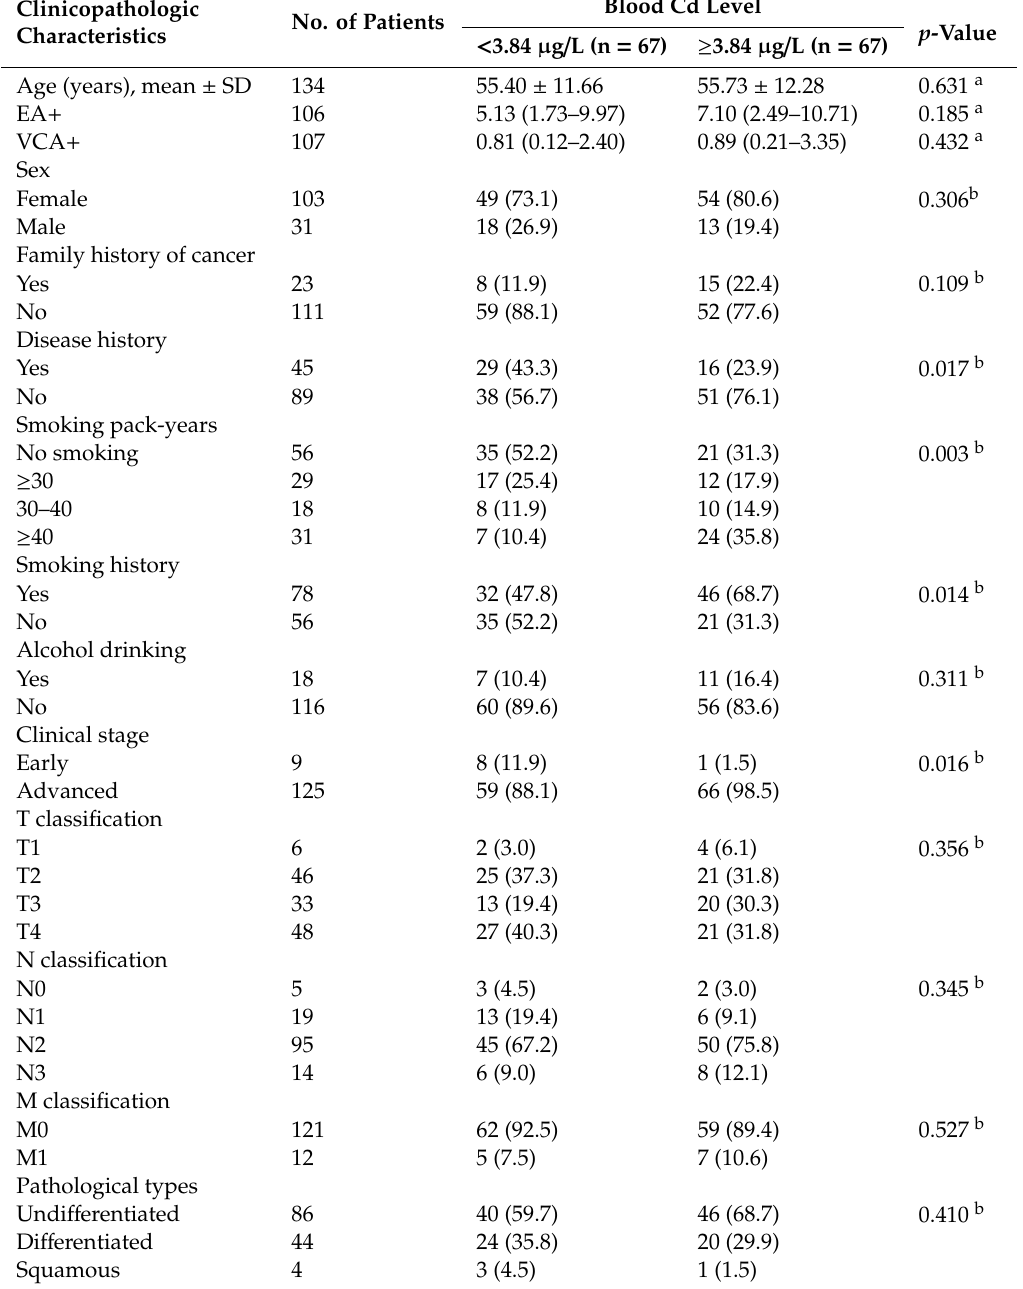
Table 2. Association between clinicopathological features and blood Cd levels with NPC (n = 134).